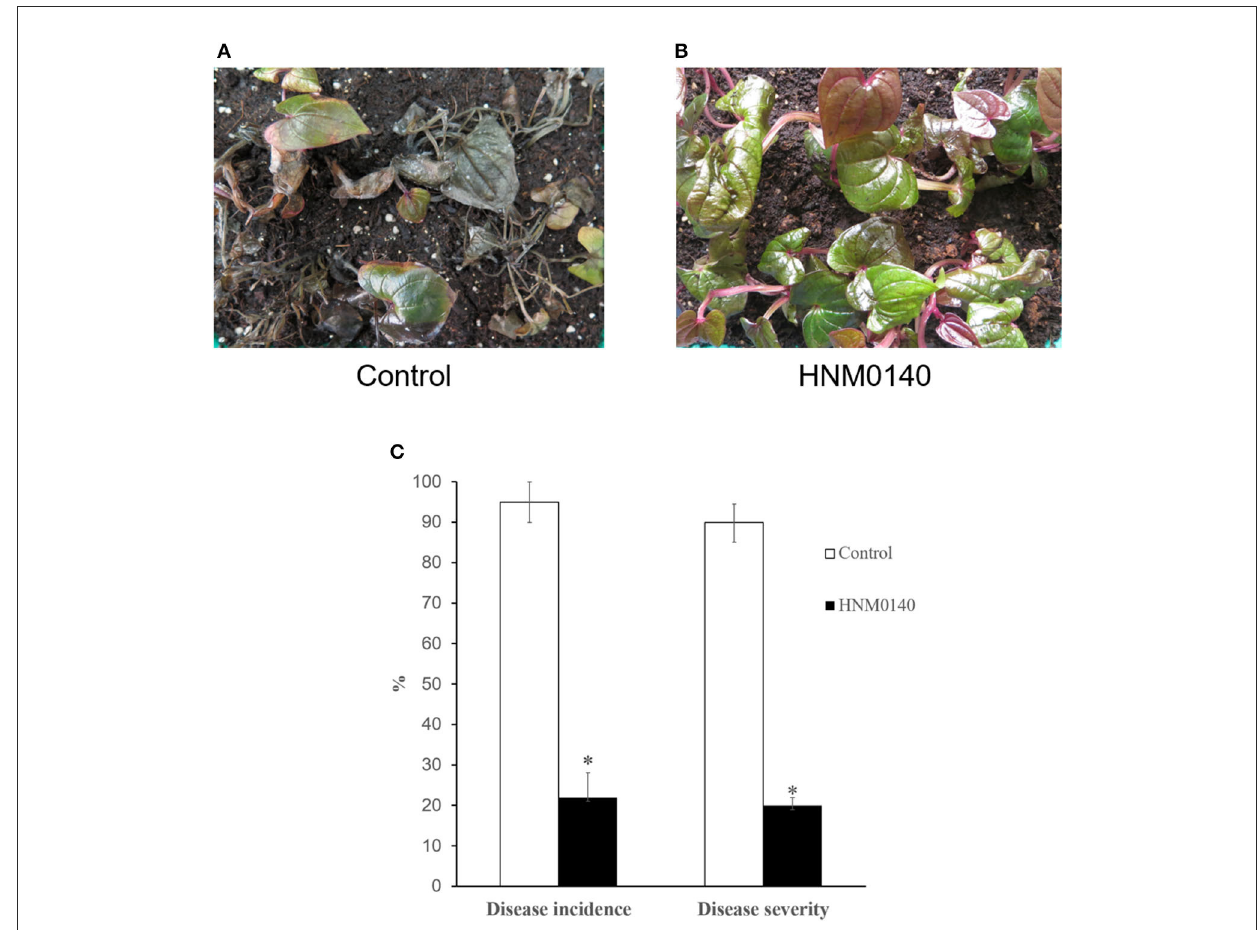
FIGURE3 Effect of strain HNM0140 T on yam anthracnose under greenhouse conditions. (A) Anthracnose symptoms on non-treated yam plants 14 days after inoculation with C. gloeosporioides. (B) Anthracnose symptoms on treated yam plants 14 days after inoculation with C. gloeosporioides. (C) Differences in disease incidence and severity of anthracnose of the treatment relative to the non-treated plants. Asterisk indicates significance in treated than in the non-treated category according to Fisher’s protected LSD test at P =